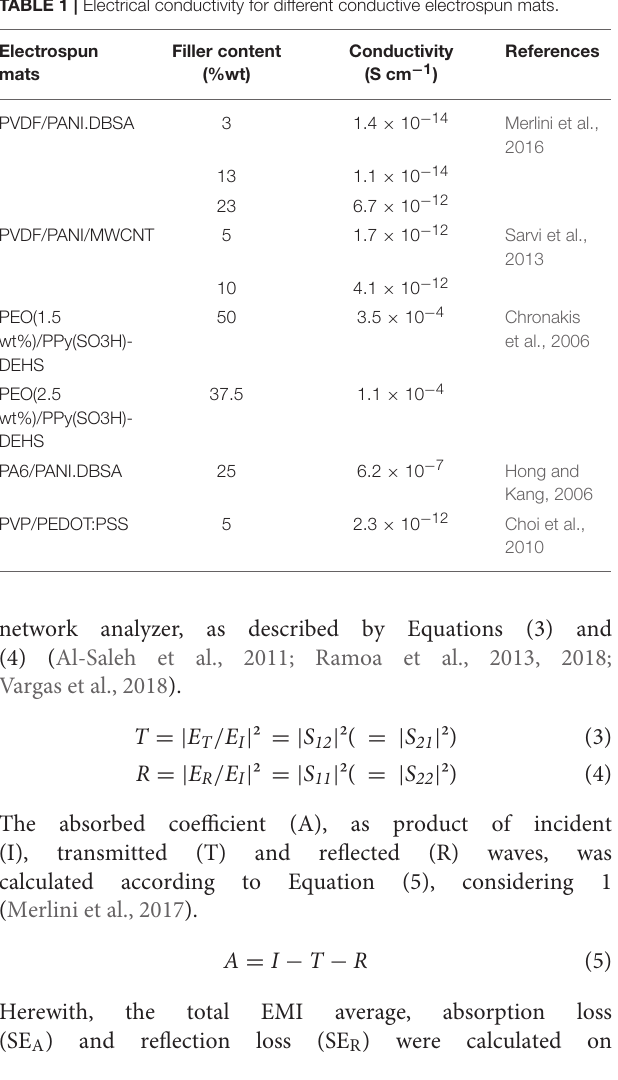
TABLE 1 | Electrical conductivity for different conductive electrospun